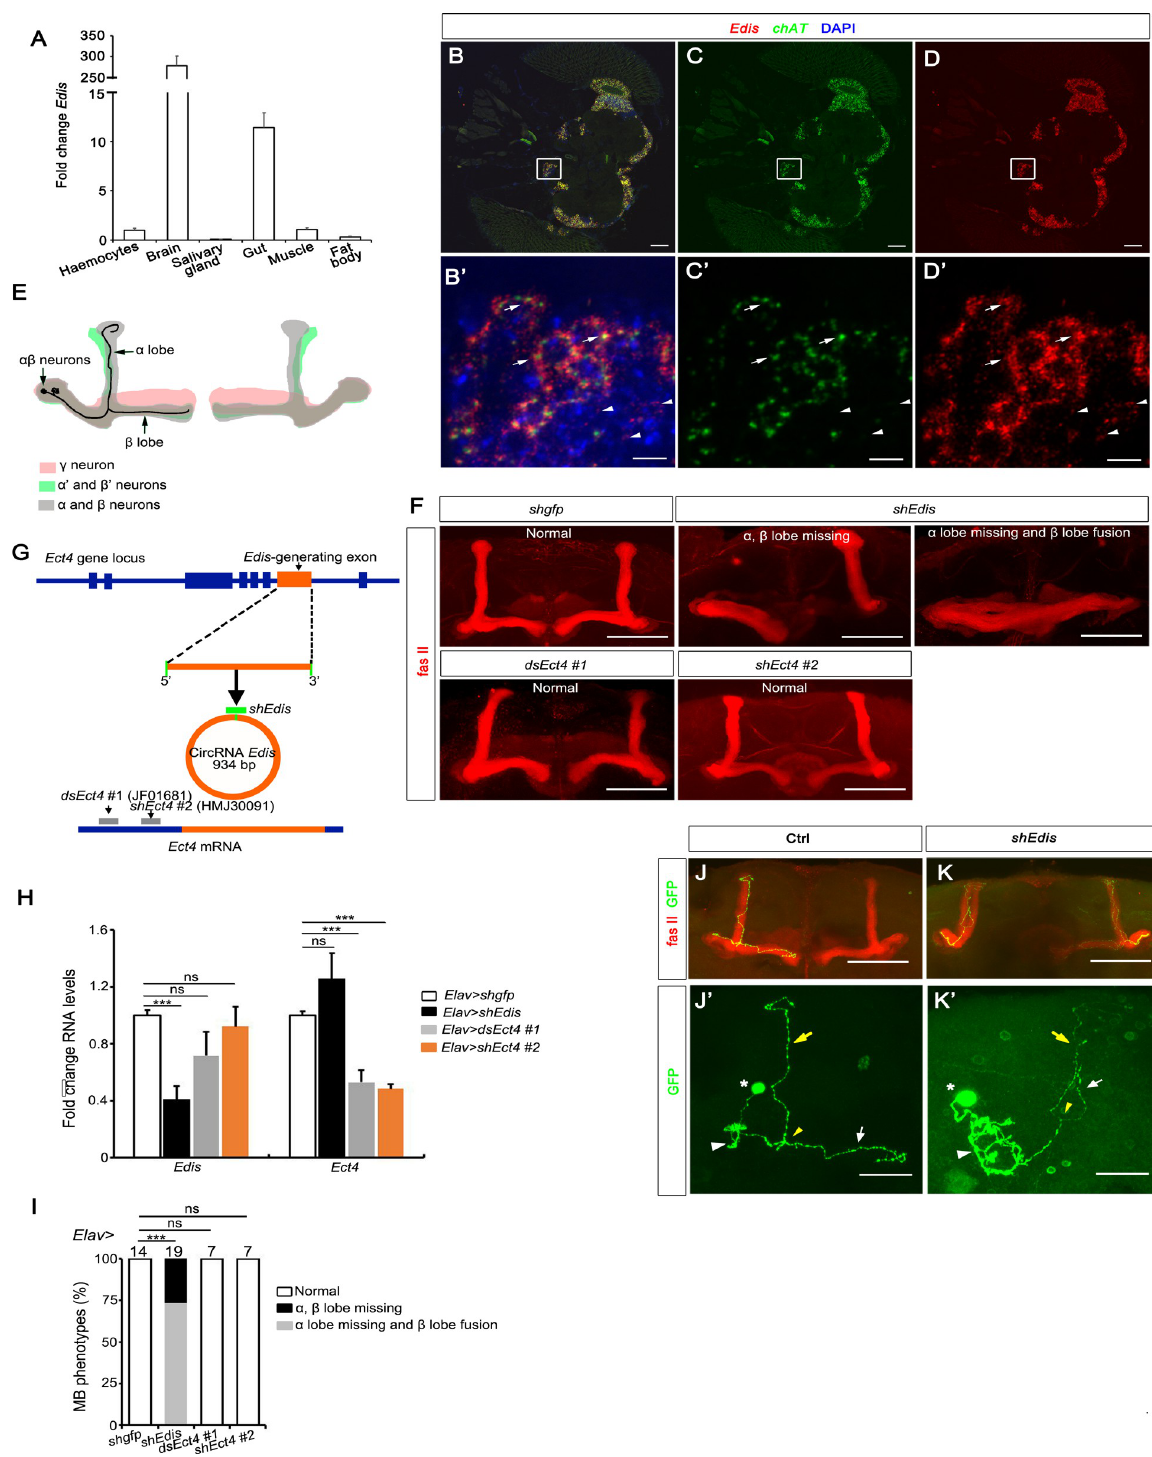
Fig 1. Edis is required for mushroom body development. ( A ) Levels of Edis in various tissues from the Drosophila 3 rd instar larvae were measured by real-time PCR (n = 3). Edis is highly expressed in the brain. Data are presented as mean + SEM. � p < 0.05; �� p < 0.01. ( B-D’ ) Fluorescence in situ hybridization (FISH) analysis of various RNAs in adult fly brains. Edis (red) is widely distributed in neurons. The mRNA encoding Choline acetyltransferase ( ChAT , green) labels cholinergic neurons. Edis is expressed in both chAT -positive (top 3 arrows) and chAT - negative (bottom 3 arrowheads) neurons. Nuclei were marked by DAPI (blue). C and D are split channels of B . B’-D’ show high